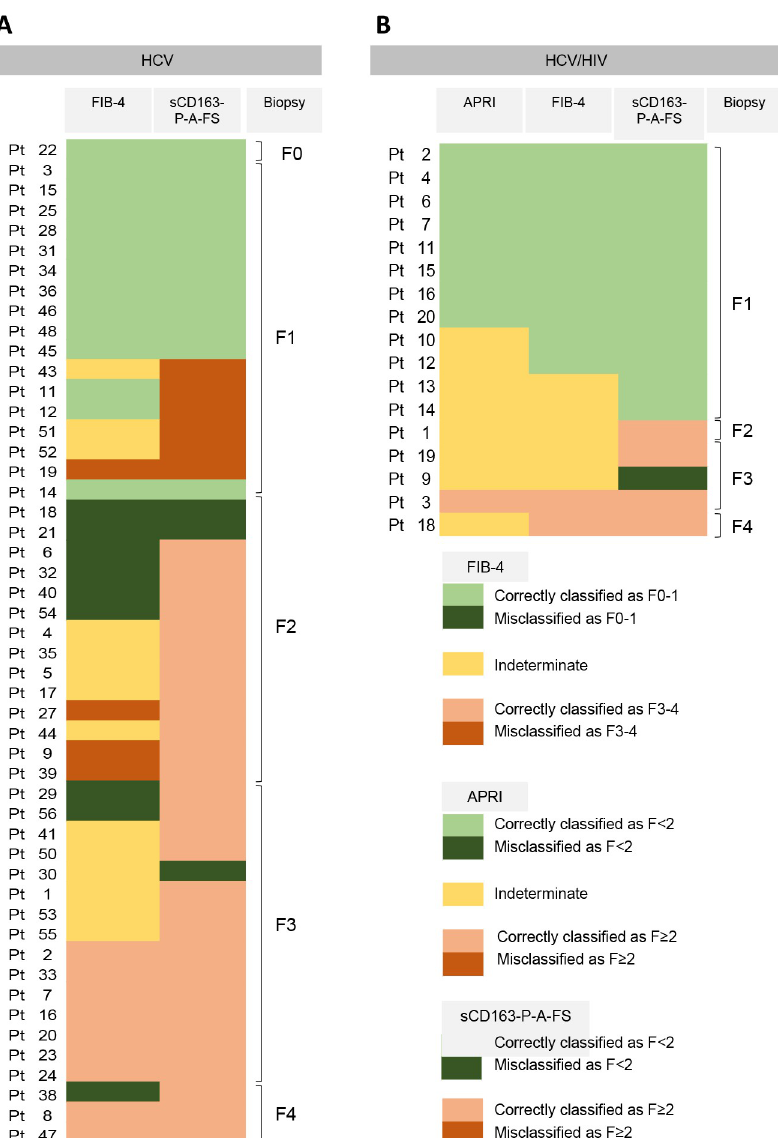
Fig 4. Evaluation of the concordance/discordance of the results obtained by APRI, FIB-4 and the proposed model. A) FIB-4 and the proposed model in HCV cases, B) APRI, FIB-4 and the proposed model in HCV/HIV cases. Low fibrosis stage: light green indicates cases correctly classified; dark green indicates cases misclassified. Yellow indicates indeterminate. High fibrosis stage: light red indicates cases correctly classified, dark red indicates cases misclassified.